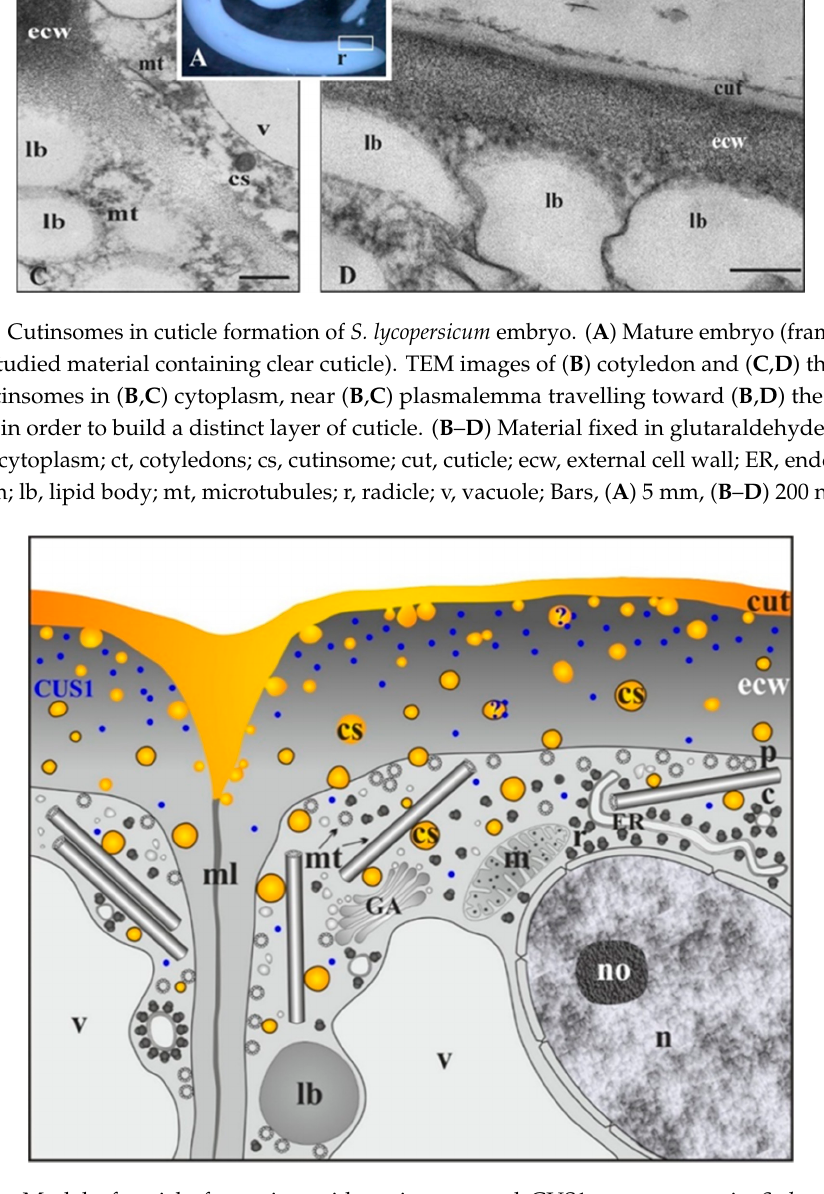
Figure 4. Model of cuticle formation with cutinsome and CUS1 engagement in S. lycopersicum . c, cytoplasm; cs, cutinsomes bordered with a shell (black ring) and without it; cut, cuticle; ecw, external cell wall; ER, endoplasmic reticulum; GA, Golgi apparatus; lb, lipid body; m, mitochondrion; ml, middle lamella; mt, microtubule; n, nucleus; no, nucleolus; p, plasmalemma; r, ribosome; v, vacuole; question marks, possible involvement of cutinsomes and CUS1.